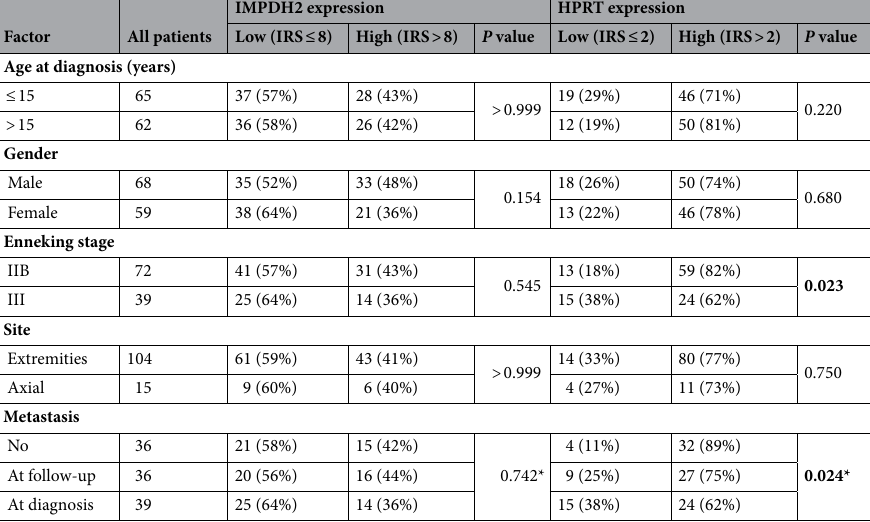
Table 1. Characteristics of osteosarcoma patients in study cohort. P values were calculated with Fisher’s exact test. * P values were calculated with Chi-square